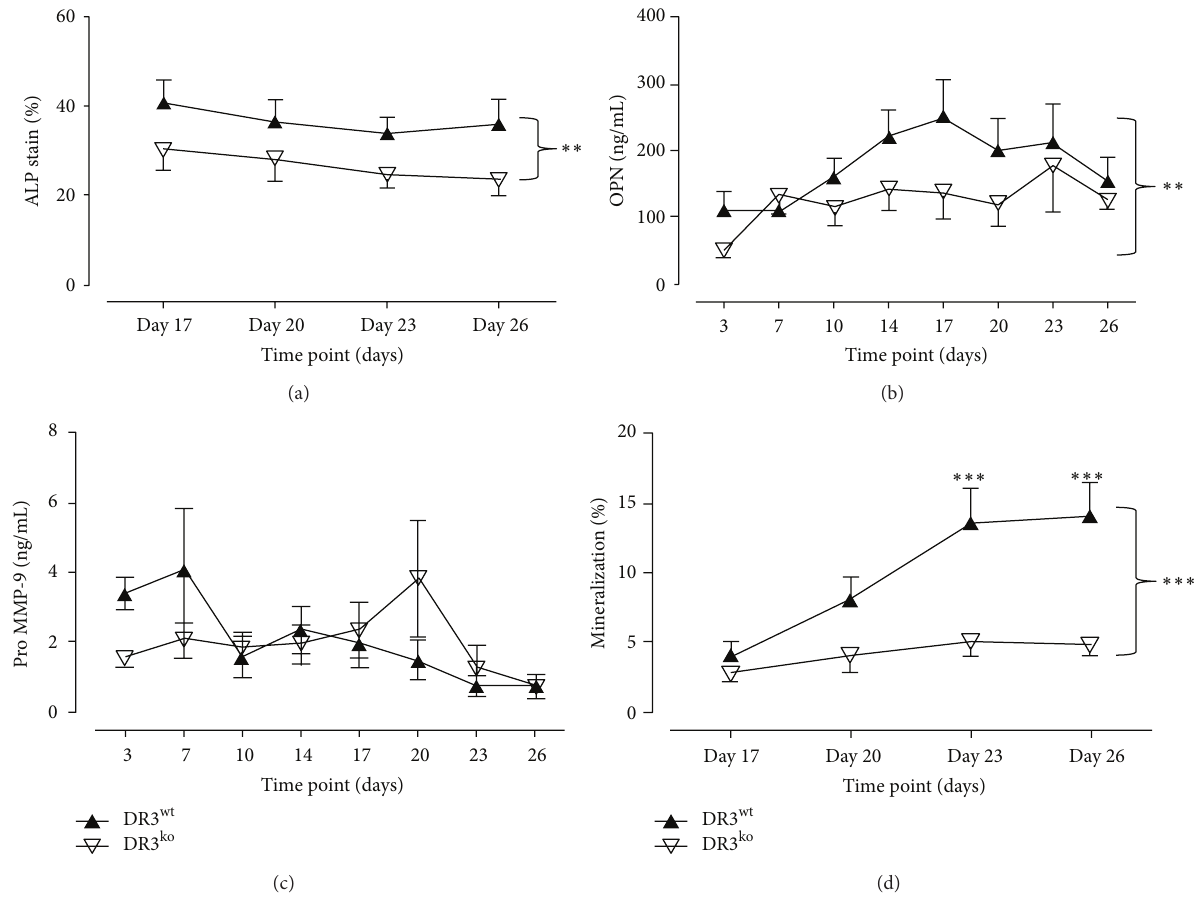
Figure 2: Expression of ALP, OPN, pro MMP-9, and mineral apposition in DR 3 wt and DR 3 ko osteoblast cultures. (a) DR 3 wt ( 𝑛 = 5 ) and DR 3 ko ( 𝑛 = 5 ) derived OB were cultured and the percentage of well area covered by ALP + cells was calculated. ALP staining was significantly higher in the DR 3 wt compared to the DR 3 ko cultures across the 26-day time course ( 𝑃 ≤ 0.01 ). Supernatants from OB cultures were tested for soluble levels of (b) OPN and (c) pro MMP-9. Across the time course significantly increased levels of OPN were detected in DR 3 wt versus DR 3 ko cultures ( 𝑃 ≤ 0.01 ). (d) Levels of mineral apposition in the cultures were tested by alizarin-red staining. Significantly increased levels of mineralization were observed in the DR 3 wt cultures at days 23 and 26 ( 𝑃 ≤ 0.001 ) compared to the DR 3 ko . This translated into a significant increase in the level of mineral apposition across the 26-day time course ( 𝑃 ≤ 0.001